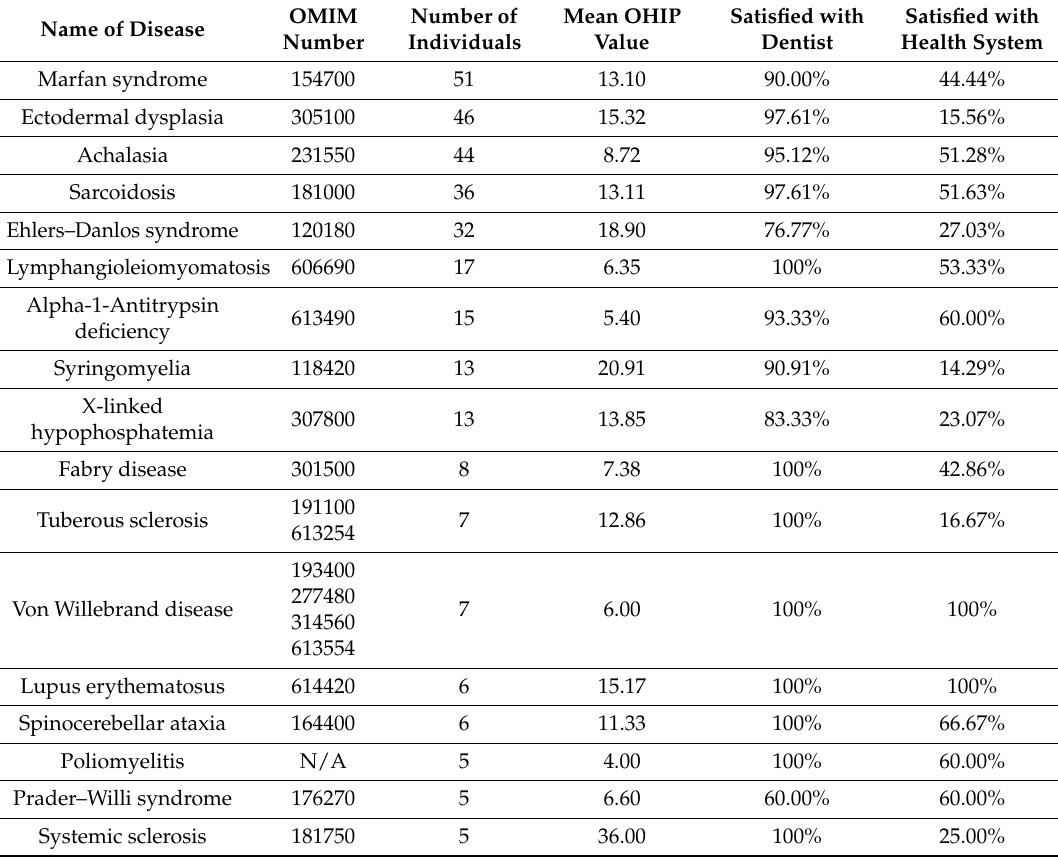
Table 1. Oral health status and satisfaction with German dental care in rare diseases. OMIM = Online Mendelian Inheritance in Man (available at